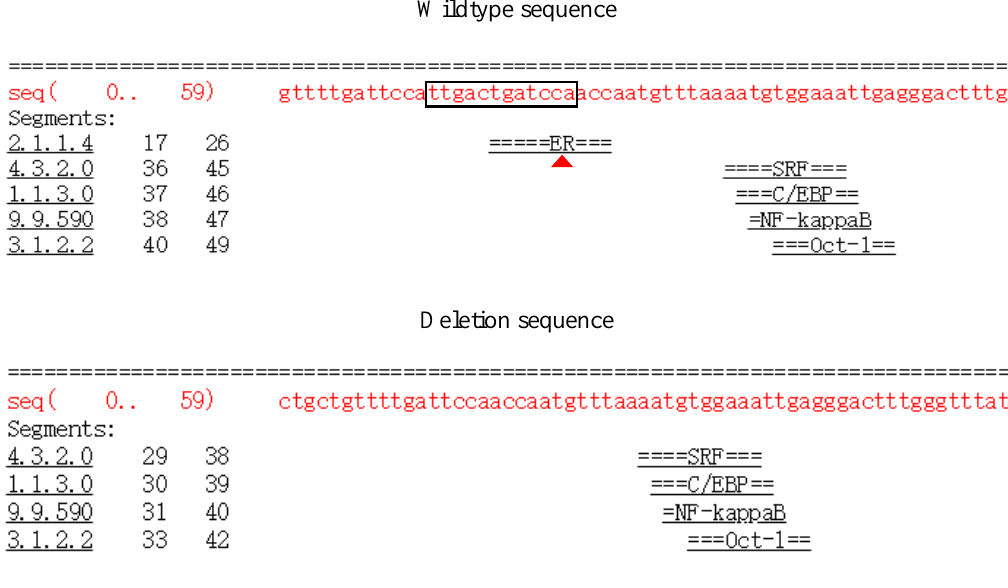
Figure 6. Bioinformatics predicted transcription factor binding sites on the 12 bp mutation sequences of the PRDM6 gene. The black box highlights the potential transcriptional factor, estrogen receptor (ER), differentially appearing in wildtype sequences. The red triangle represents the differential binding of transcription factors.